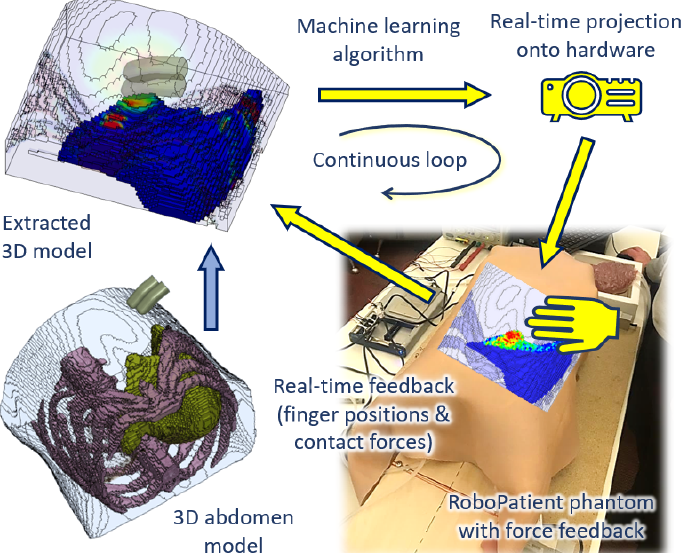
Figure 1. An overview of the real-time internal abdomen visualisation with respect to force feedback from the robotic patient simulator based on the surrogate model. The surrogate model is trained by using a machine learning algorithm to render tissue deformation by using the input force and palpation location performed by the